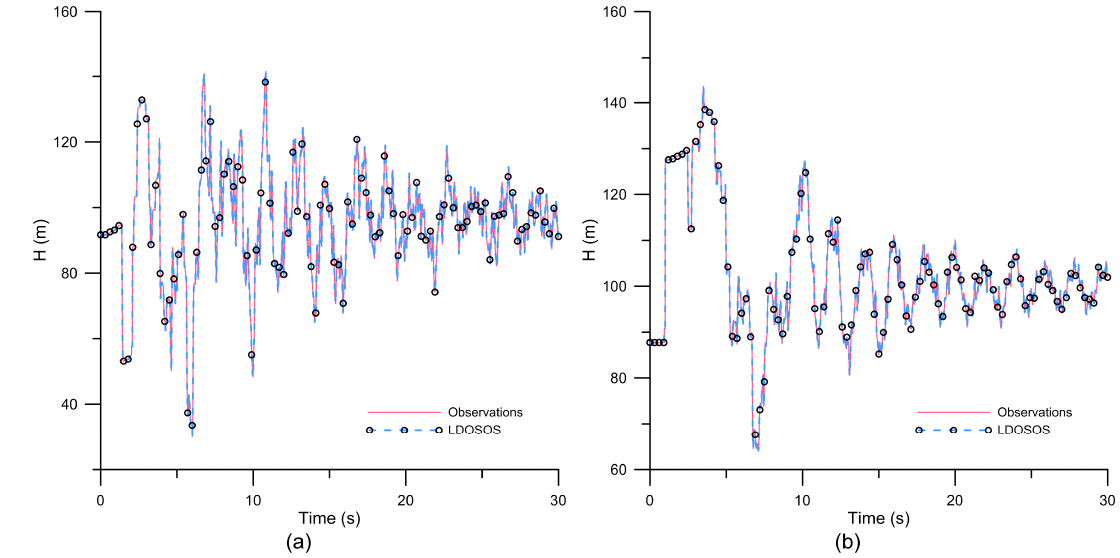
Figure 8. Simulated head distributions observed at ( a ) N8 and ( b ) N9. Table 5. Estimated leak information for S2 using N8 or N9.